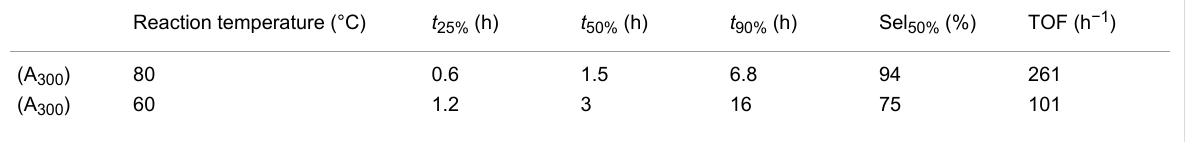
Table 2: Catalytic performance of (A 300 ) catalyst (2 µmol Au) in the oxidative reaction of benzyl alcohol in toluene at 80 °C and 60 °C (1 atm of air): 25%, 50% and 90% conversion time ( t ), benzaldehyde selectivity at half conversion (Sel 50%) and turn over frequency (TOF).